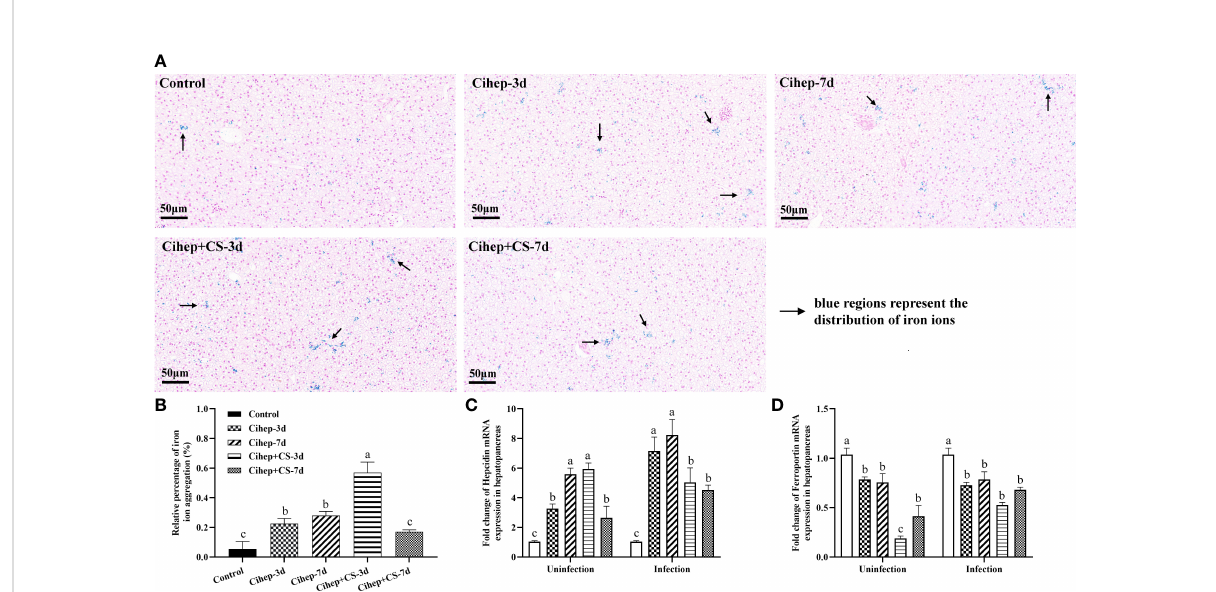
FIGURE 5 Regulation of hepatopancreas iron and iron metabolism-related genes by Cihep and CS. (A) Iron distribution in hepatopancreas. Using the PBS group as the control, the iron content in hepatopancreas was stained by Prussian blue, bar = 50 m m. Arrowheads in the image show the iron content in hepatopancreas. (B) The Prussian blue-stained sections from (A) were analyzed with ImageJ image-analysis software to calculate the relative percentage of iron ion aggregation. (C) mRNA expression expression of hepcidin gene in hepatopancreas. (D) mRNA expression expression of ferroportin gene in hepatopancreas. Different small letters in each group (a, b, and c) denote signi fi cant variations suggested by the multifactorial ANOVA statistics (p < 0.05).